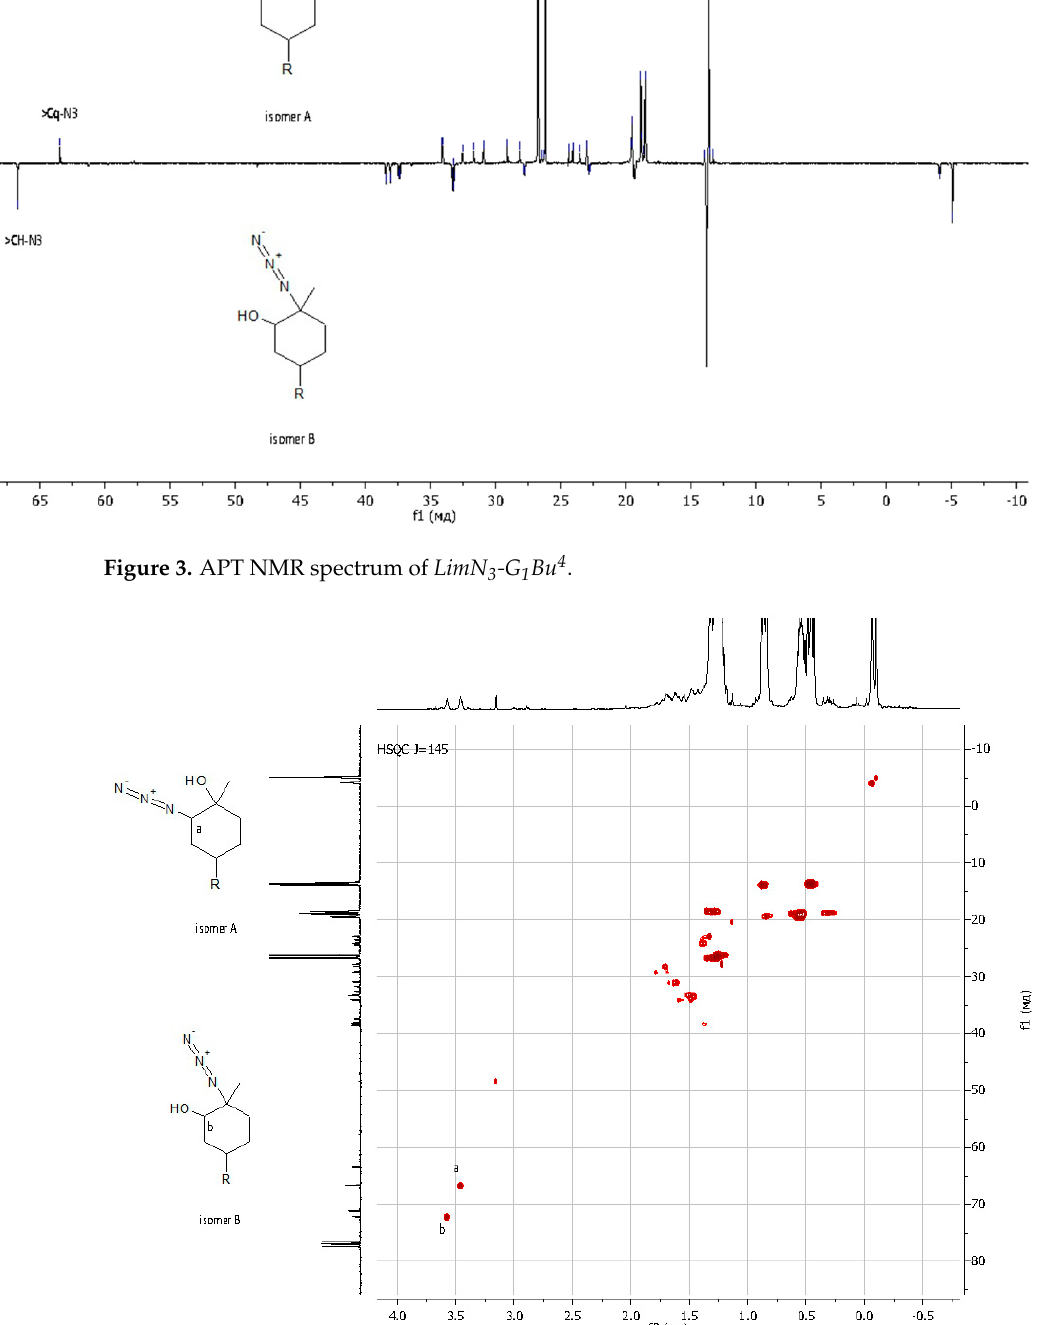
Figure 4. { 1 H 13 C} HSQC NMR spectrum of LimN 3 -G 1 Bu 4 .